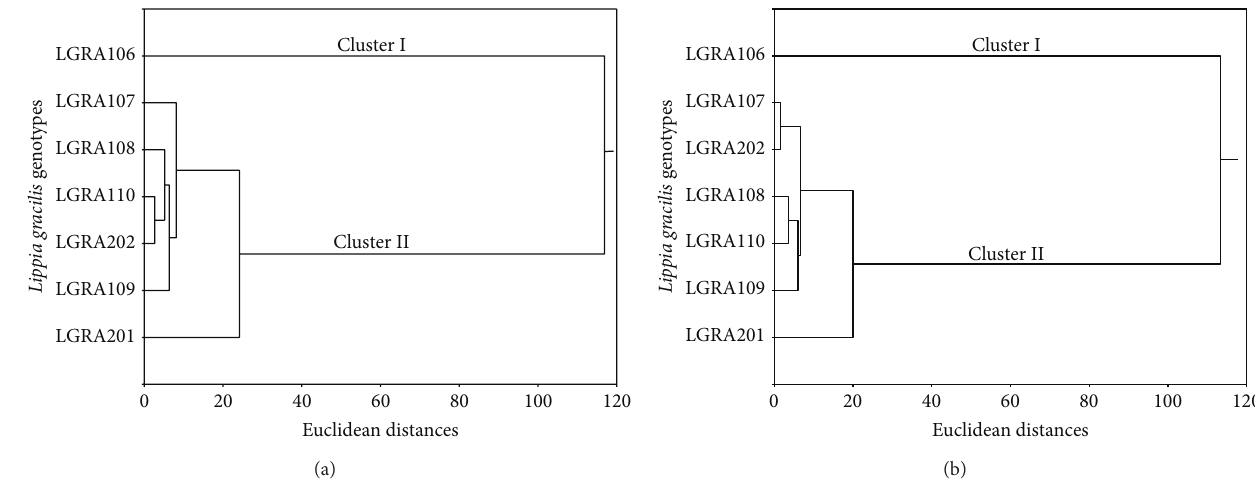
Figure 2: Bidimensional dendrograms representing the similarity of the chemical composition between seven L. gracilis genotypes for plants harvested in the rainy (a) and dry (b) seasons.